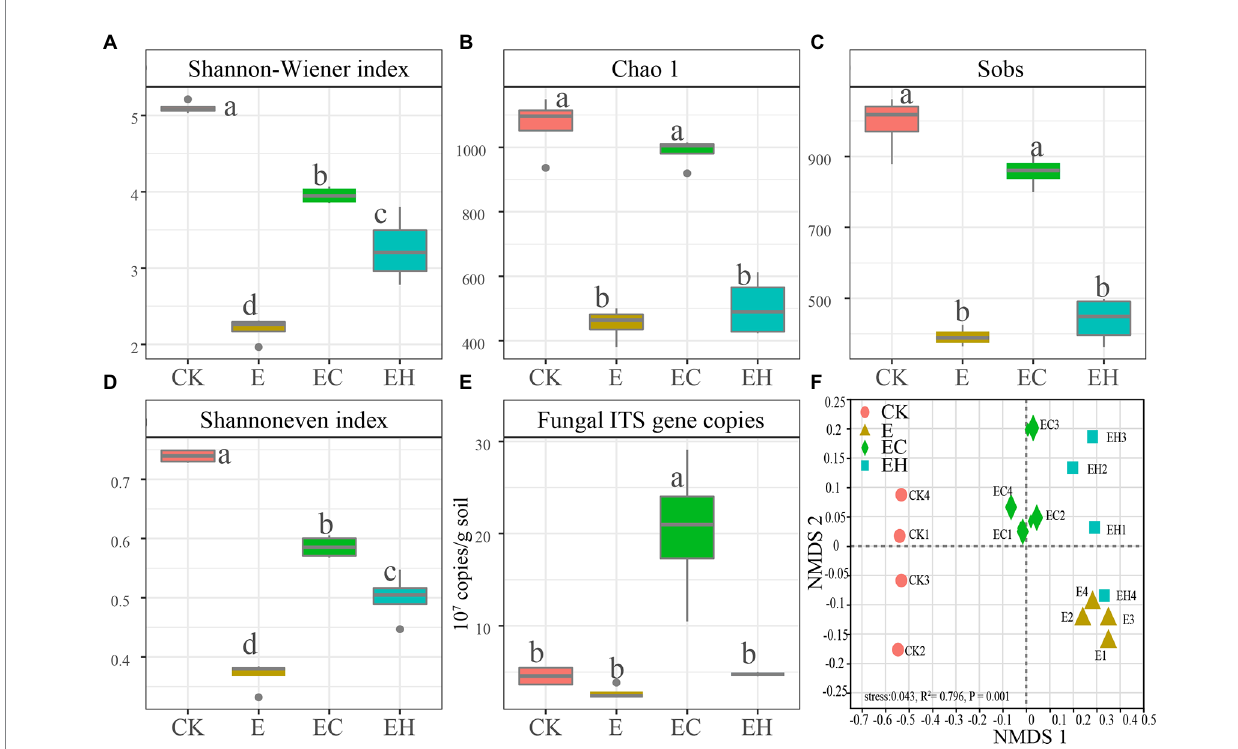
FIGURE 2 Soil fungal community diversity and gene copies in pure eucalypt plantations (CK, E) and mixed plantations (EC, EH). (A) Shannon–Wiener index, (B) Chao 1 index, (C) Sobs index: number of OTUs actually observed, (D) Shannon even index, (E) Fungal ITS gene copies. Different lowercase letters above the bar chart in different colors indicate significant differences at the 0.05 level, and (F) Non-metric multidimensional scaling analysis of soil fungal communities base on Bray–Curtis distance. CK, the first rotation of E. urophylla plantations; E, the third rotation of E. urograndis plantations; EC, mixed plantations of E. urograndis and Cinnamomum camphora ; EH, E. urograndis and Castanopsis hystrix .